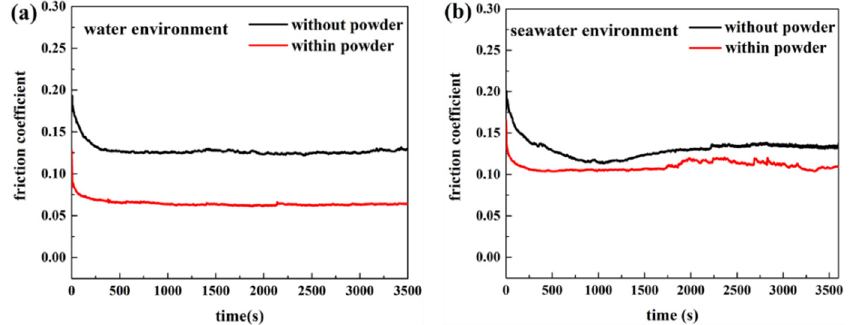
Figure 3. The friction coefficient of the UHMWPE pin in ( a ) water and ( b ) seawater environments.